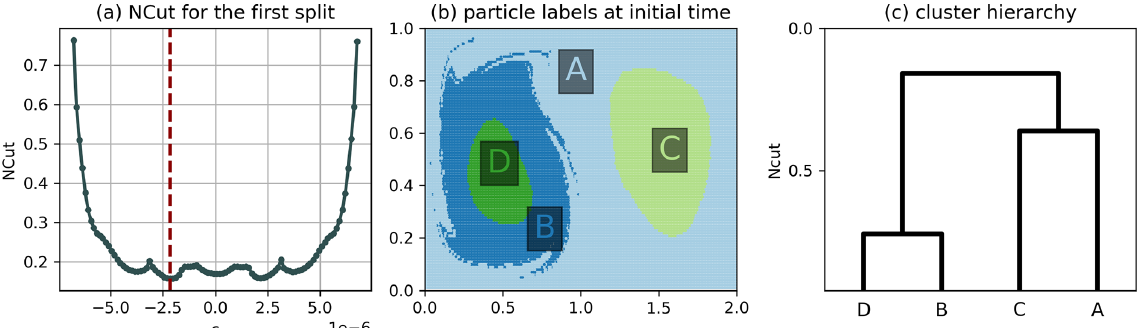
Figure B6. Hierarchical clustering result of the double gyre using algorithm 2 of Sect. 3.3 and (cid:49)x = (cid:49)y = 0 . 1. (a) NCut for the first split as a function of the cutoff c , where c = 0 corresponds to a cut along the transport boundary, the red line indicating the minimum found by our algorithm. (b) Result of the hierarchical clustering. (c) Dendrogram representing the hierarchy, where the horizontal lines correspond to the NCut value after each split. There is only a local minimum at c = 0, which is why the transport boundary is still not detected. This situation is similar to the one described by Froyland and Padberg (2009) for the transfer operator framework.